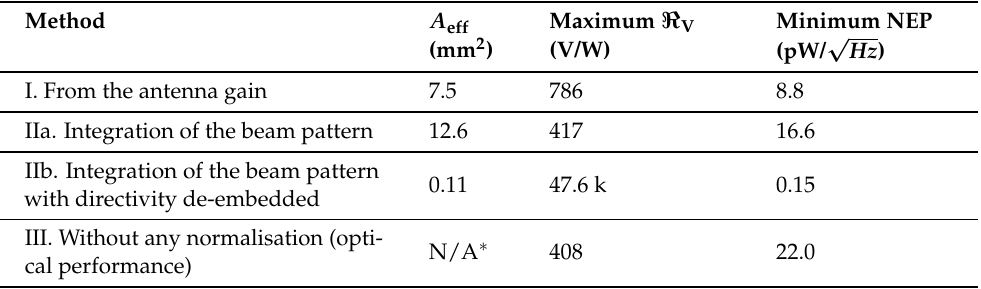
Table 1. Comparison of responsivity and NEP of the FET-based detector at 252 GHz, considering different methods calculating the effective area and/or the impinging